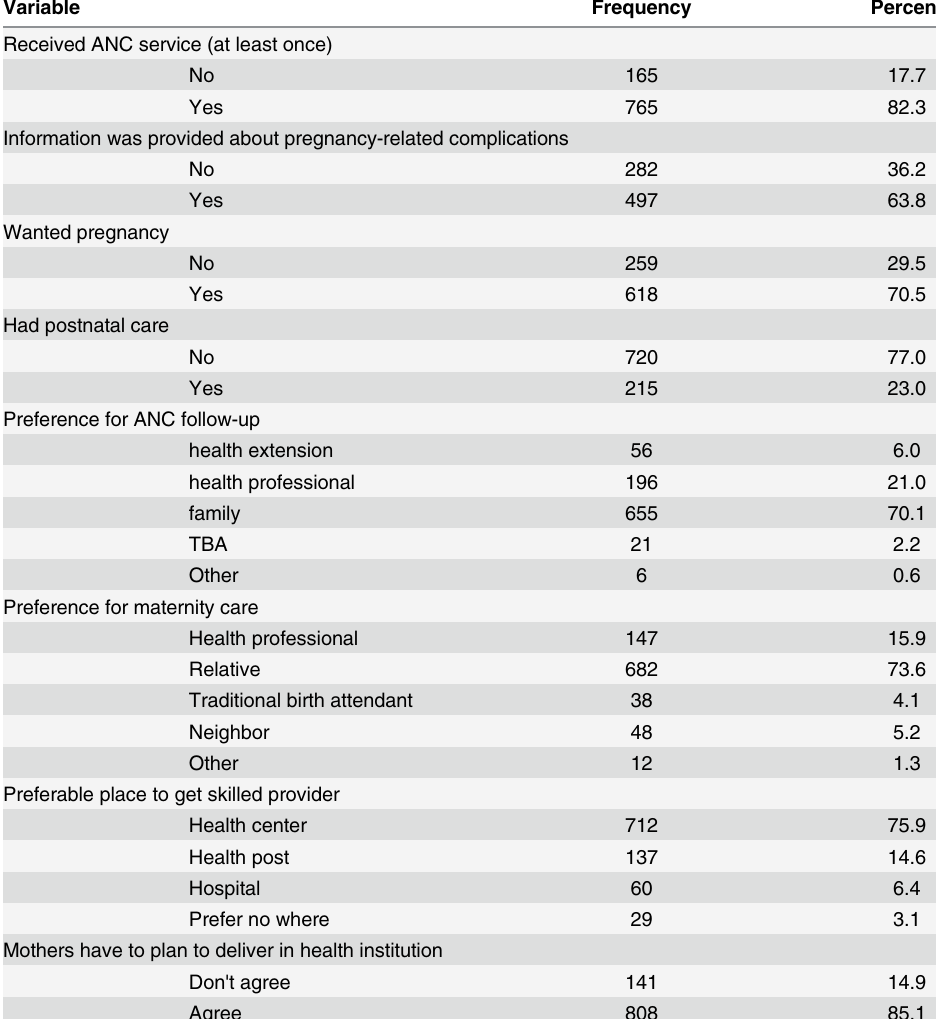
Table 2. Health service utilization of study participants, assessment of institutional delivery service utilization in Wolaita and Dawro zone,